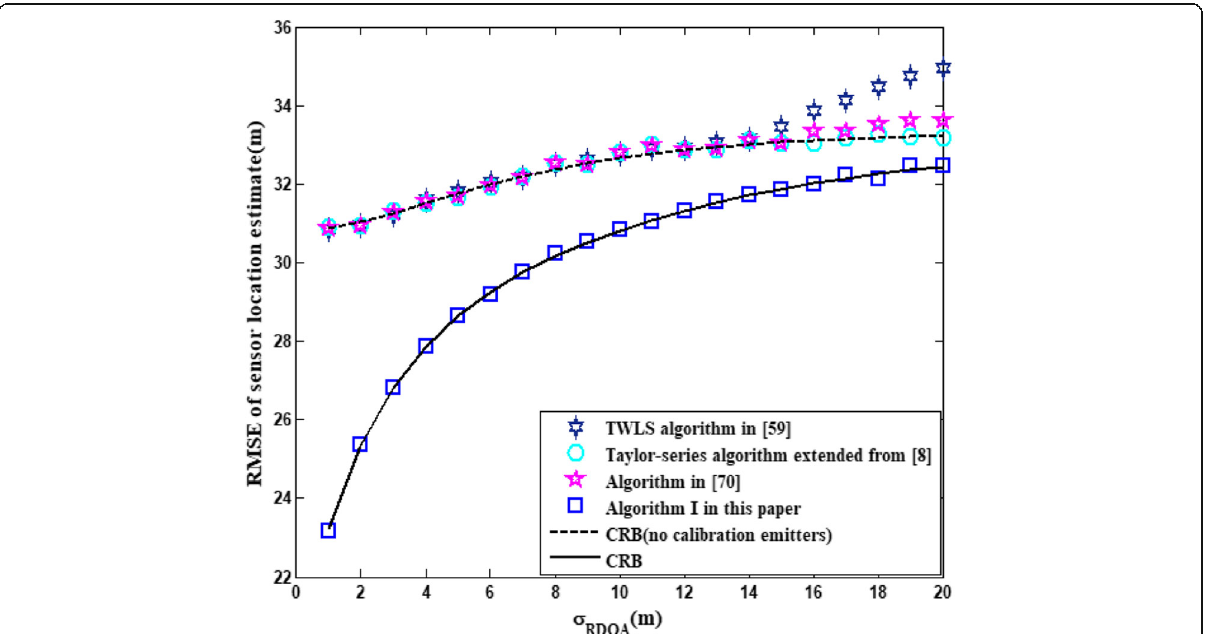
Fig. 7 RMSE of sensor location estimate versus σ RDOA